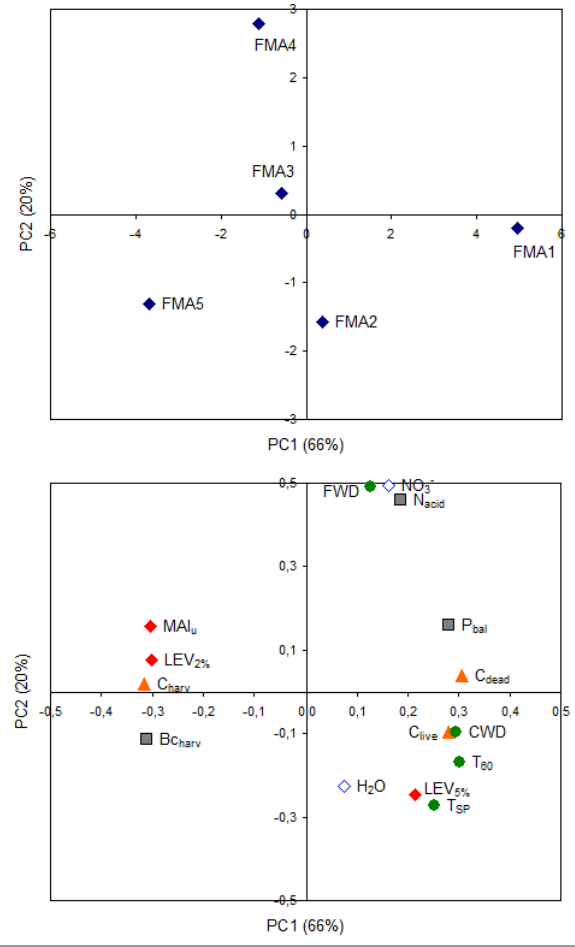
Fig. 3 . Results of the principal component analysis based on a subset of Table 3 indicators. Upper panel: the differences between FMAs across all considered functions could be summarized in two dimensions, with PC1 explaining 66% of the variation in the indicator set, and PC2 explaining 20%. Lower panel: the PC loadings of the individual indicators grouped for each service—productive functions (diamond), carbon (triangle), nutrients/acidification (shaded square), water (open diamond), and biodiversity